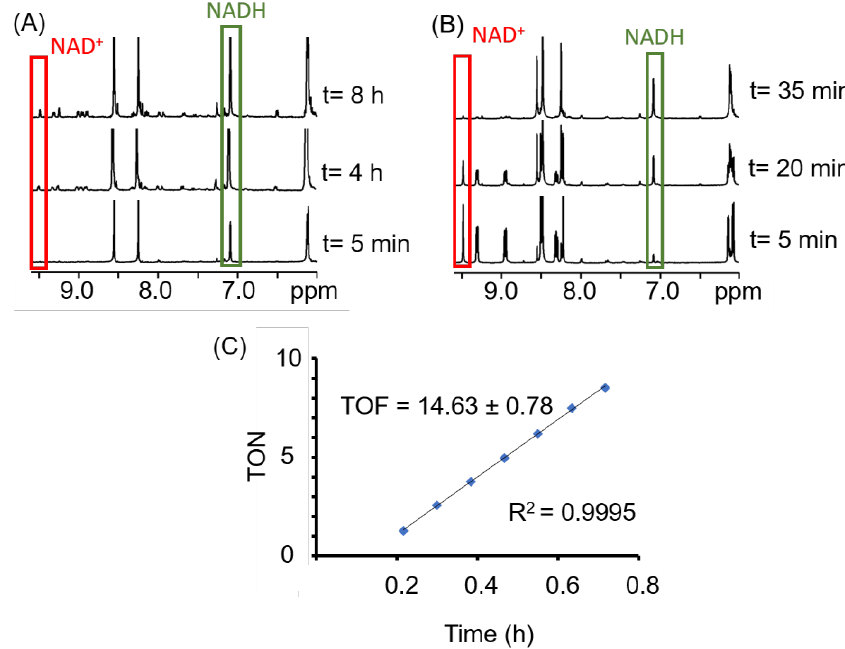
Figure 3. Kinetic experiments of complex 1 with 10 mol. equiv. NADH ( A ), or 9 mol. equiv. NAD + and 28 mol. equiv. formate ( B ). Plot of the turnover number (TON) of the reaction of complex 1 with 28 mol. equiv. formate and 9 mol equiv. NAD + versus time to calculate the turnover frequency (TOF) of the reaction ( C ). 1 H-NMR spectra were recorded in MeOD / D 2 O (1 / 1 v / v ), pH 7.4 and 310 K. Table 2. IC 50 values ( µ M) in A2780, A2780 cisplatin resistant and PNT2 cells for complexes 1 – 4